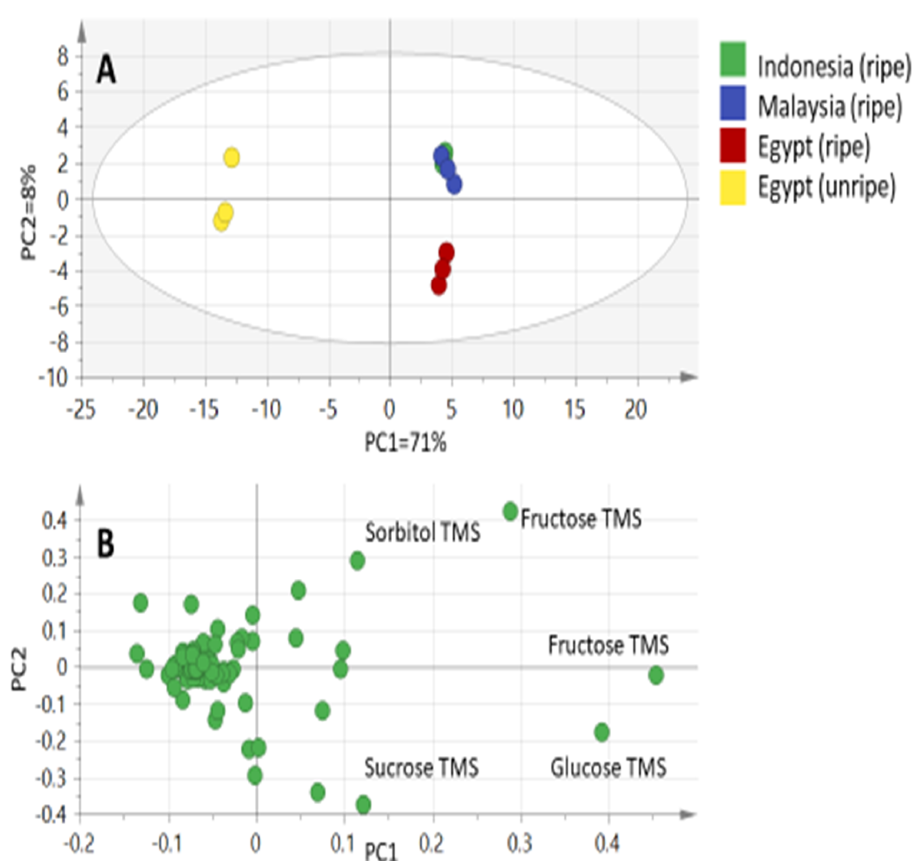
Figure 2. Principal component analyses of ripe and unripe silylated fruit extracts as analyzed by GC-MS ( n = 3). ( A ) Score plot of PC1 vs. PC2 scores. ( B ) Loading plot for PC1 and PC2 contributing mass peaks and their assignments.